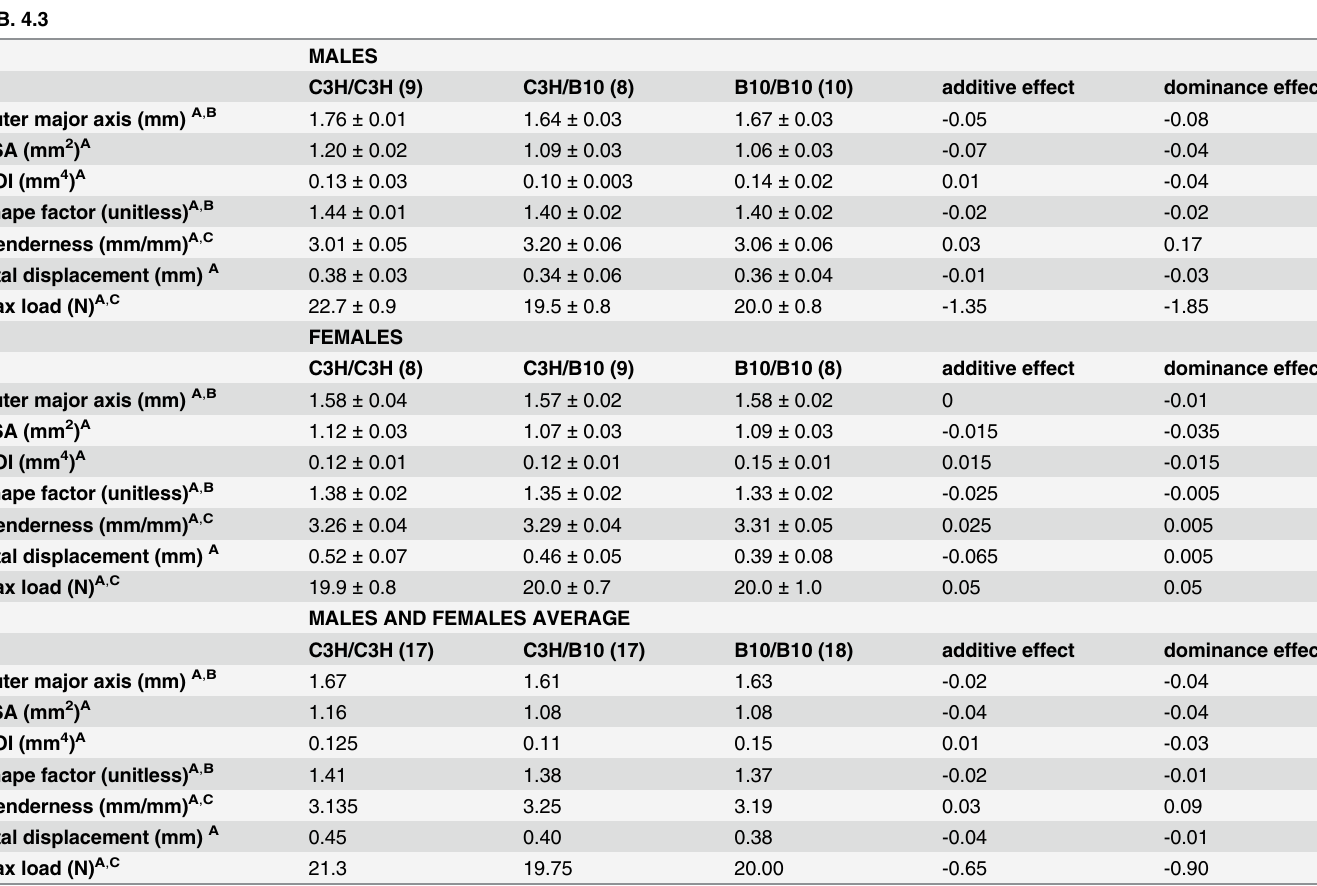
Table 4. Additive and Dominance Effects for Chromosome 4 QTL in C.B.4.3